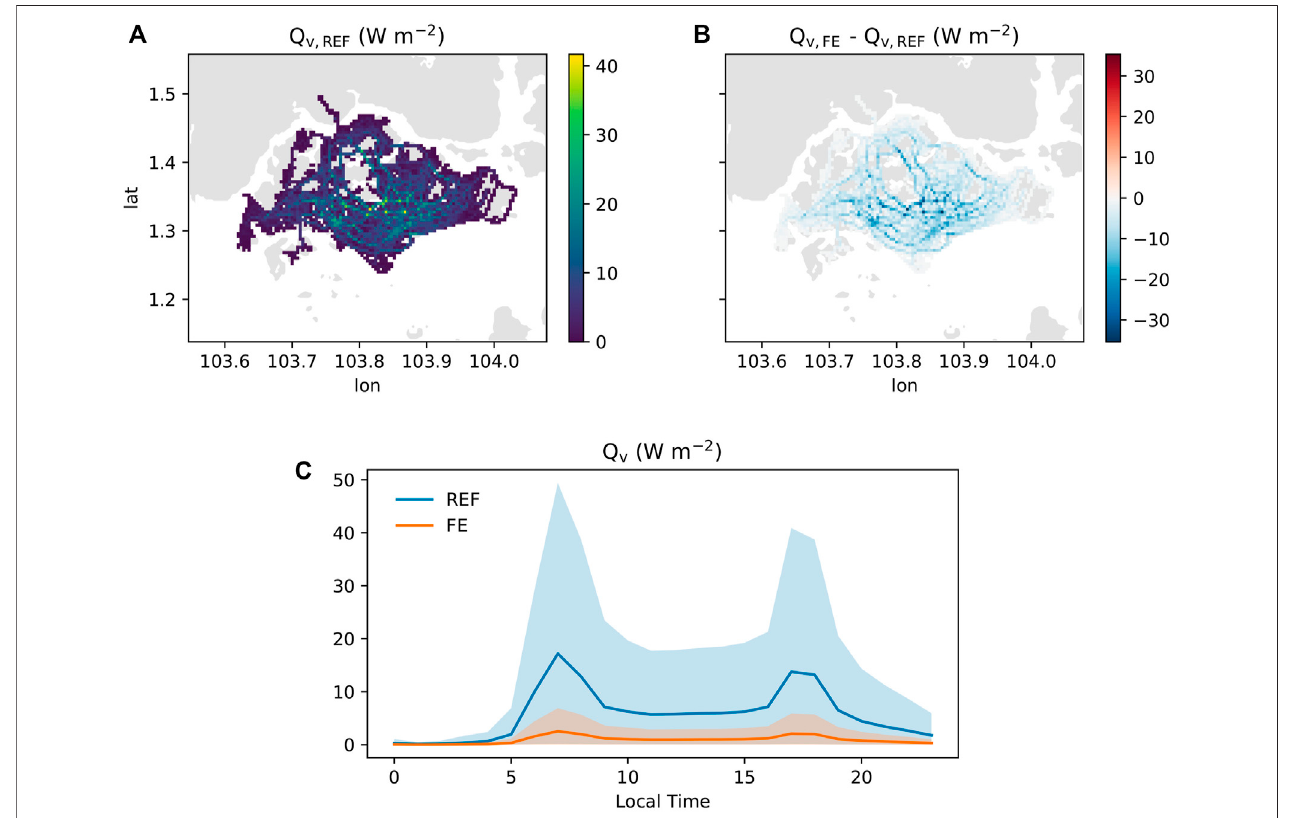
FIGURE 1 | Sensible heat emissions from vehicles ( Q v ). (A) shows the spatial distribution of the daily-averaged Q v in the scenarios REF (current vehicles composition); (B) shows the difference between FE (full fl eet electri fi cation) and REF; (C) shows the diurnal evolution of Q v in the two scenarios, where solid lines and shaded areas show the mean value and the variability between 5th and 95th percentiles, respectively. The grey area in (A) and (B) represents land